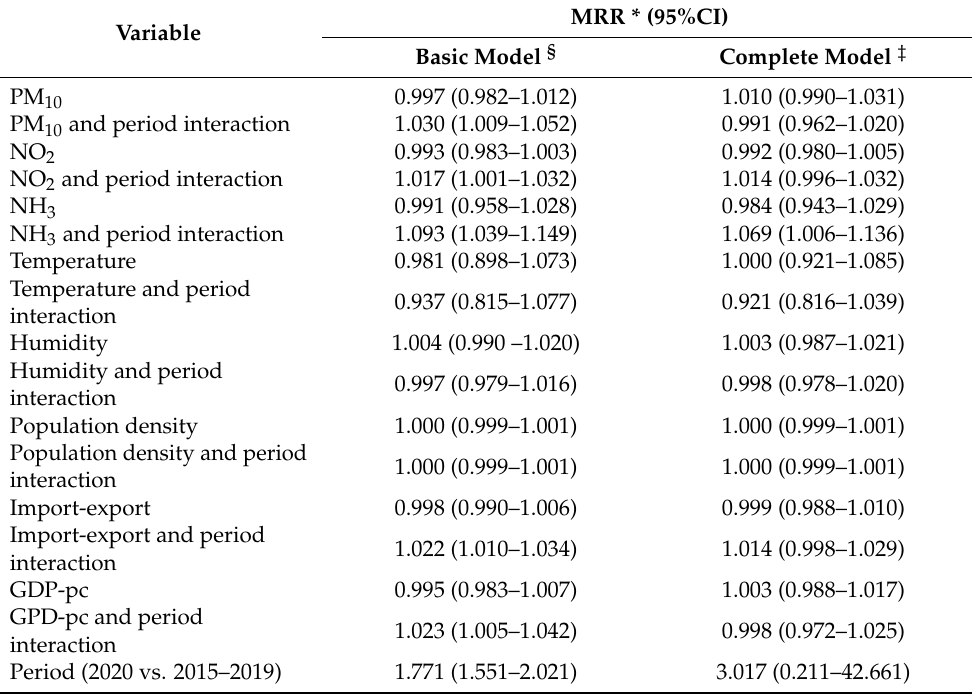
Table 2. Mortality rate ratios (MRRs) * with 95% confidence intervals (CI) for all 43 Italian provinces included in the